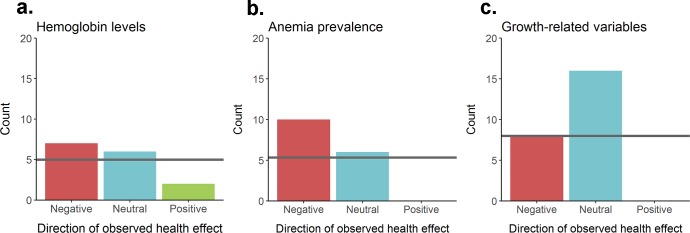
Direction of reported health outcomes of helminth co-infections for (a) hemoglobin levels, (b) anemia prevalence, and (c) growth-related variables. Horizontal line indicates expected value assuming the null hypothesis of equal proportions.